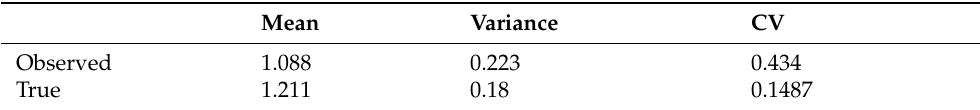
Table 4. Comparison of the mean, variance and CV for the first-passage times of the observed and true degradation. Mean Variance CV Observed 1.088 0.223 0.434 True 1.211 0.18